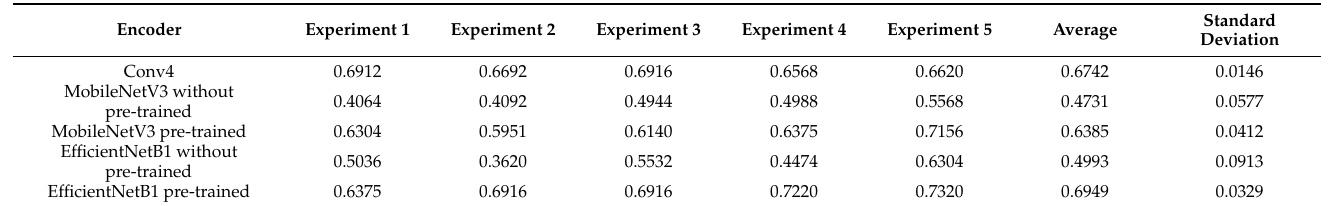
Table 3. Accuracy results of application of various encoder few-shot models to the validation set.